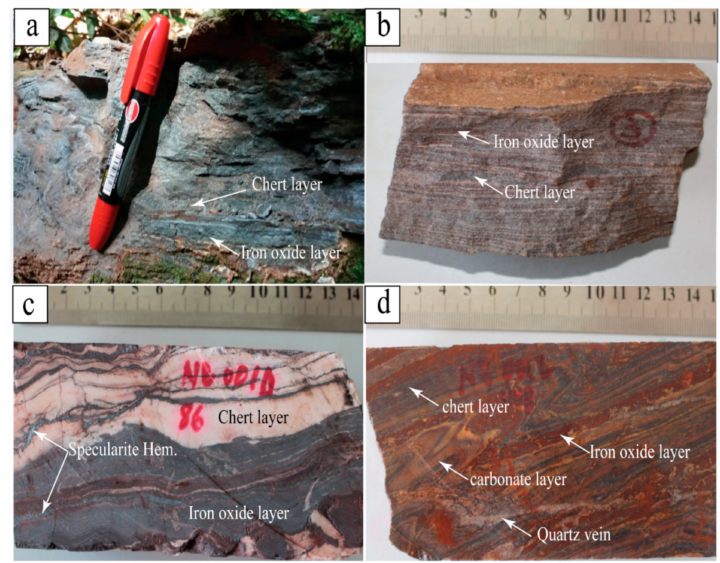
Figure 4. Field photos of ( a ) BIF outcrop at Nabeba, showing minor folding of the alternating hematite and chert layers; ( b ) oxide facies-BIF, showing the fine alternating layers of chert and iron oxides; ( c ) oxide facies-BIF, showing the fine alternating layers of chert, specularite, and magnetite, ( d ) slightly-folded carbonate-oxide facies-BIF, showing the alternating carbonate, magnetite, and chert